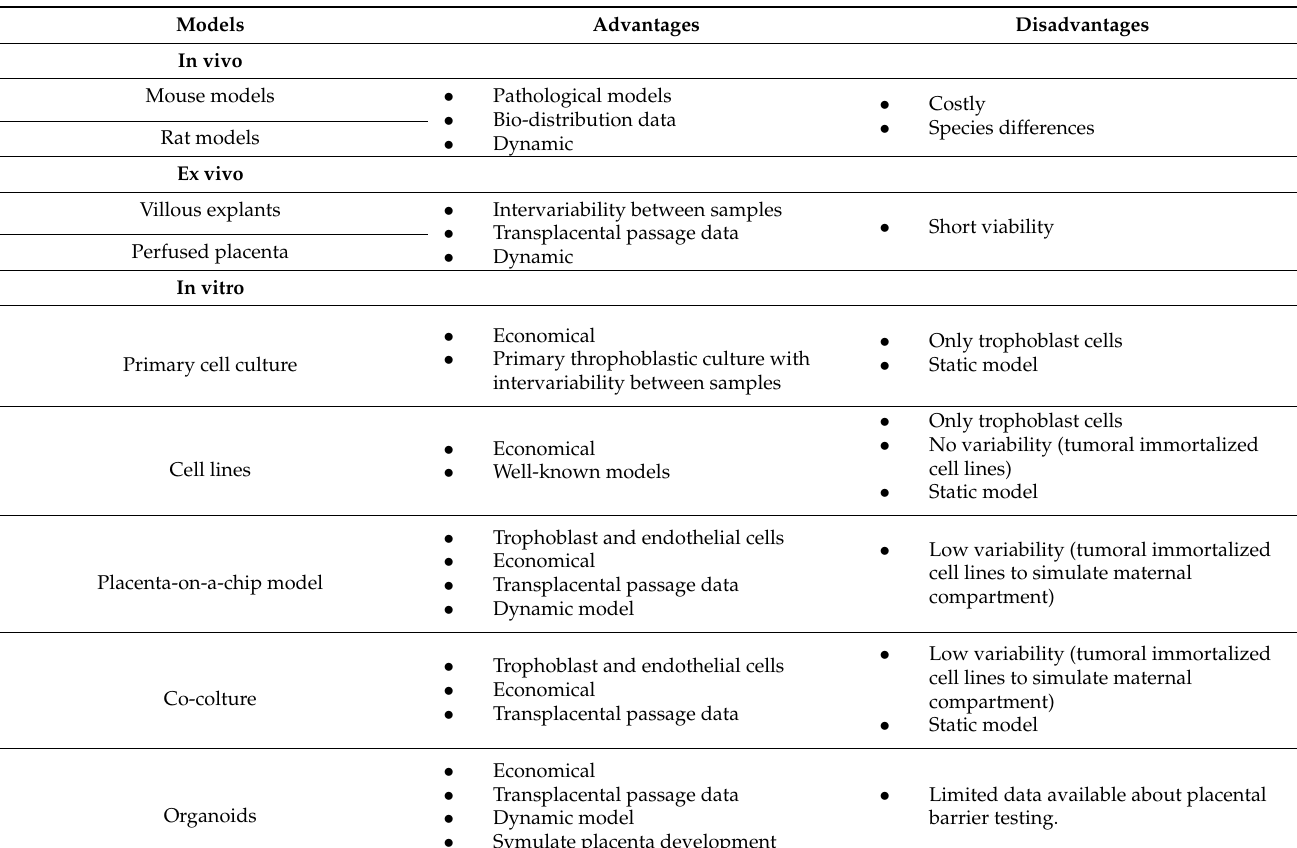
Table 1. Experimental models of the